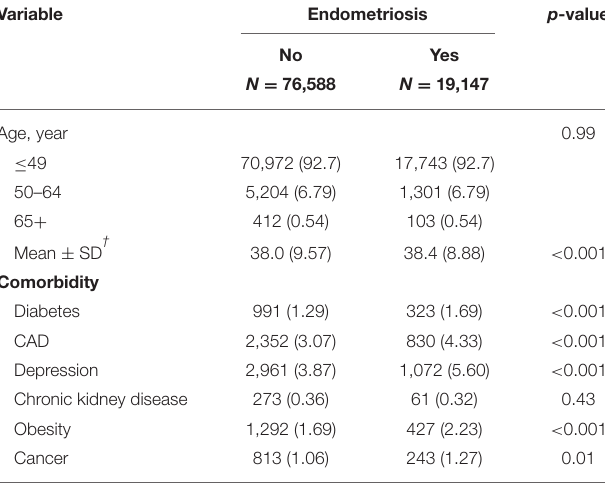
( ± 8.88) years for the control group ( Table 1 ). The majority of TABLE 1 | Demographic characteristics and comorbidities in cohorts with and without